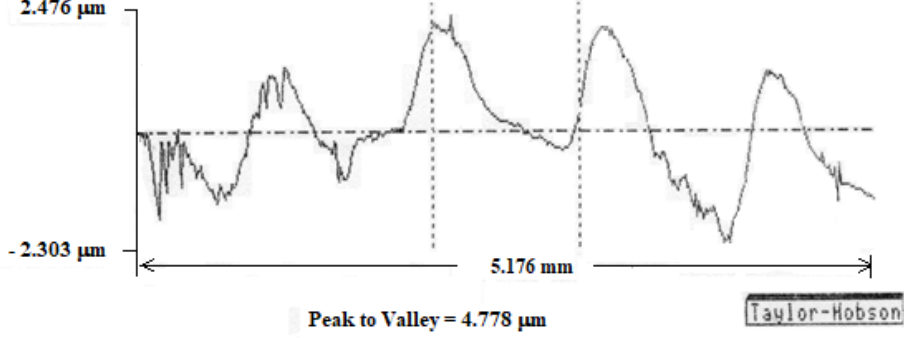
Figure 10. The topography of the manufactured surface, measured on Talysurf 120L.